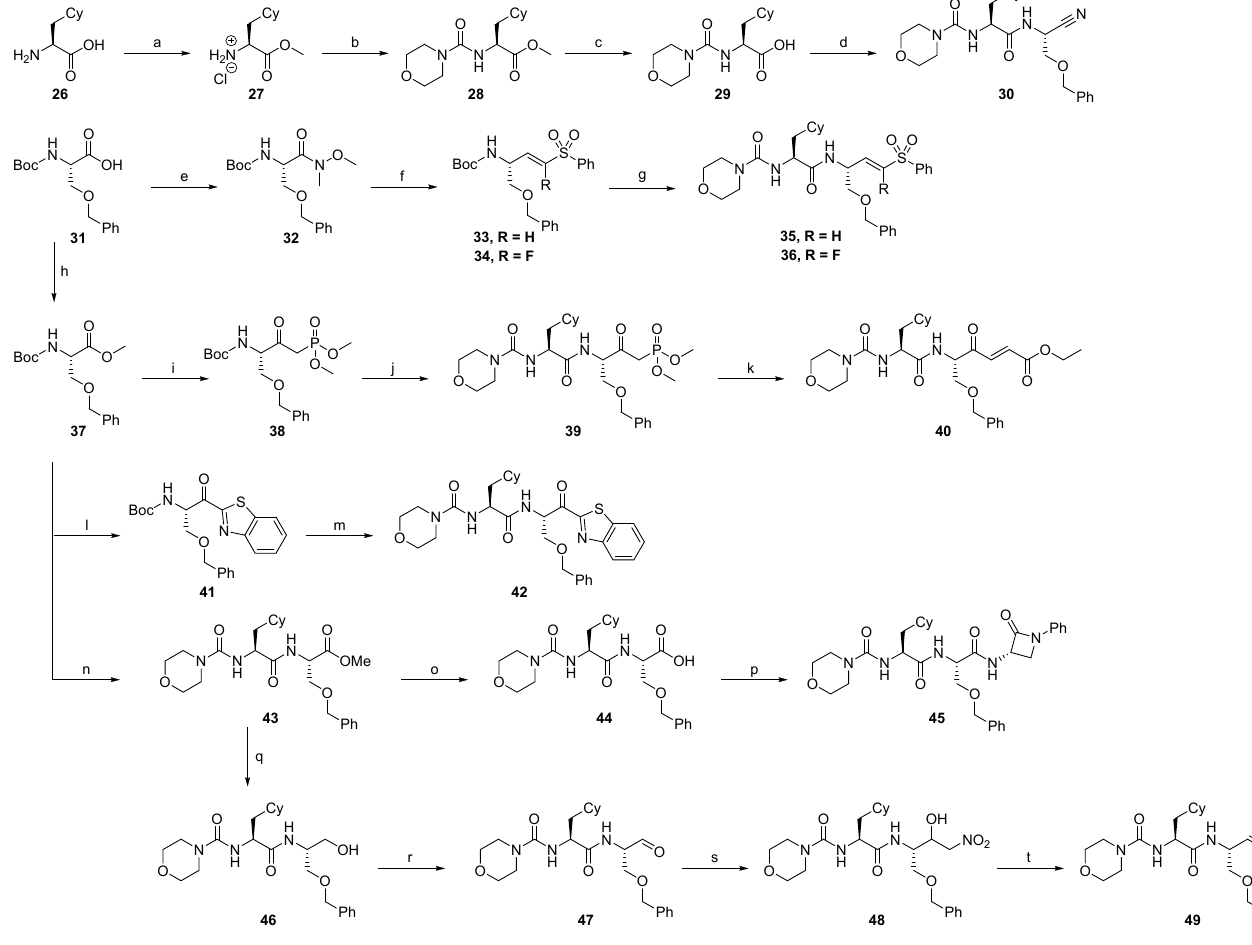
Scheme 3. Synthesis of cathepsin S compounds. Reaction conditions: (a) SOCl 2 , MeOH, –10 °C, 16 h, 91%; (b) morpholine, triphosgene, NaHCO 3 , CHCl 2 , 0 °C; 16 h, 98%; (c) LiOH, THF/H 2 O, 3 h, 97%;